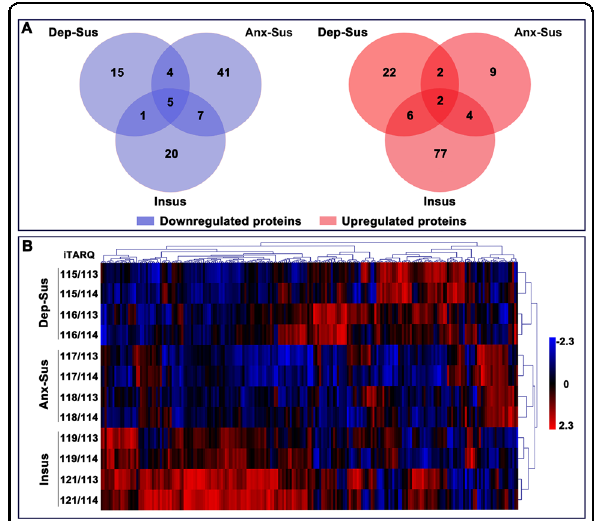
Fig. 2 Expression analysis of the identi fi ed differentially expressed proteins. A Venn diagrams displaying the differential protein number among the depression-susceptible (Dep-Sus), anxiety- susceptible (Anx-Sus), and insusceptible (Insus) groups. B Clustering of differential proteins from the three groups using a visualized heatmap. Lower expressions were shown by blue and higher by red. Various color intensities indicated the expression levels and a log2 scale was used in the color bar. The included eight labels were indicated on the y